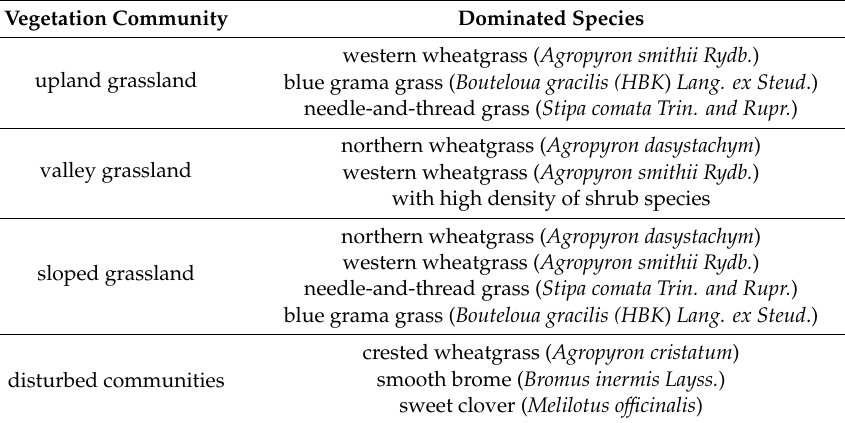
Table 1. Dominant species in upland, sloped, valley and disturbed communities. Vegetation Community Dominated Species western wheatgrass ( Agropyron smithii Rydb. ) upland grassland blue grama grass ( Bouteloua gracilis (HBK ) Lang. ex Steud .) needle-and-thread grass ( Stipa comata Trin. and Rupr. ) northern wheatgrass ( Agropyron dasystachym ) valley grassland western wheatgrass ( Agropyron smithii Rydb. ) with high density of shrub species northern wheatgrass ( Agropyron dasystachym ) western wheatgrass ( Agropyron smithii Rydb. ) sloped grassland needle-and-thread grass ( Stipa comata Trin. and Rupr. ) crested wheatgrass ( Agropyron cristatum ) smooth brome ( Bromus inermis Layss. ) disturbed communities